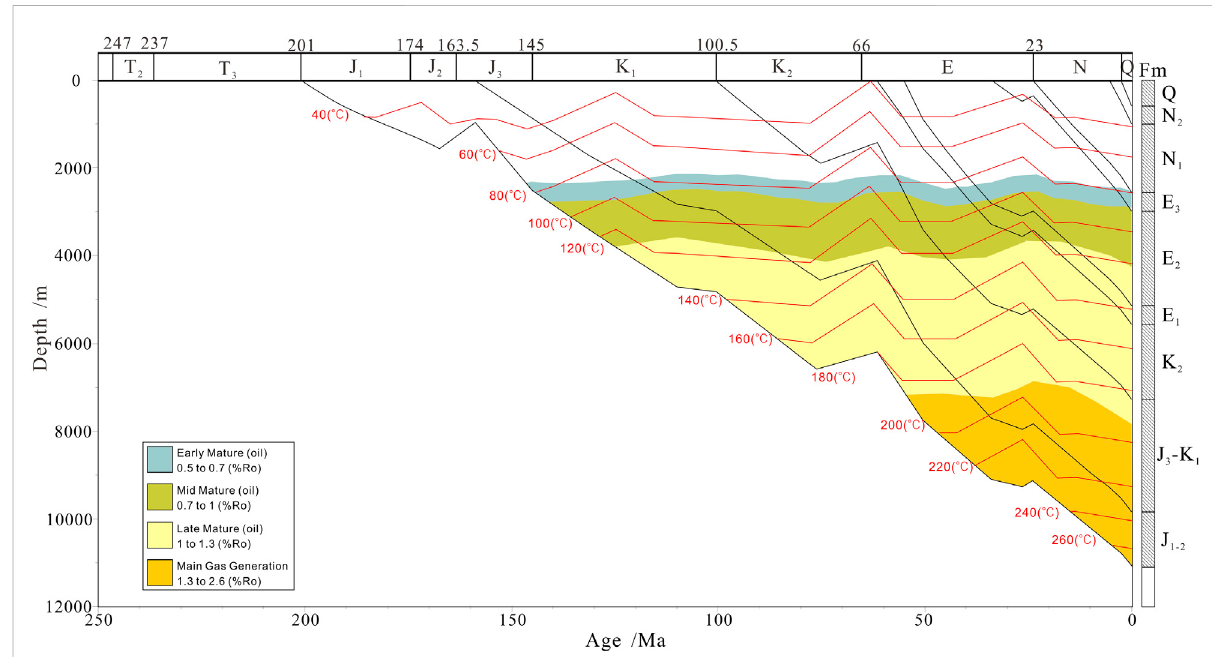
FIGURE 9 Burial history and thermal evolution at the Keelung sag (well location is shown in Figure 1). The fi ll colors represent different stages of maturity evolution. The J 1-2 label represents the Early – Middle Jurassic; J 3 -K 1 represents the Late Jurassic – Early Cretaceous; K 2 represents the Late Cretaceous; E 1 represents the Paleocene; E 2 represents the Eocene; E 3 represents the Oligocene; N 1 represents the Miocene; N 2 represents the Pliocene; and Q represents the